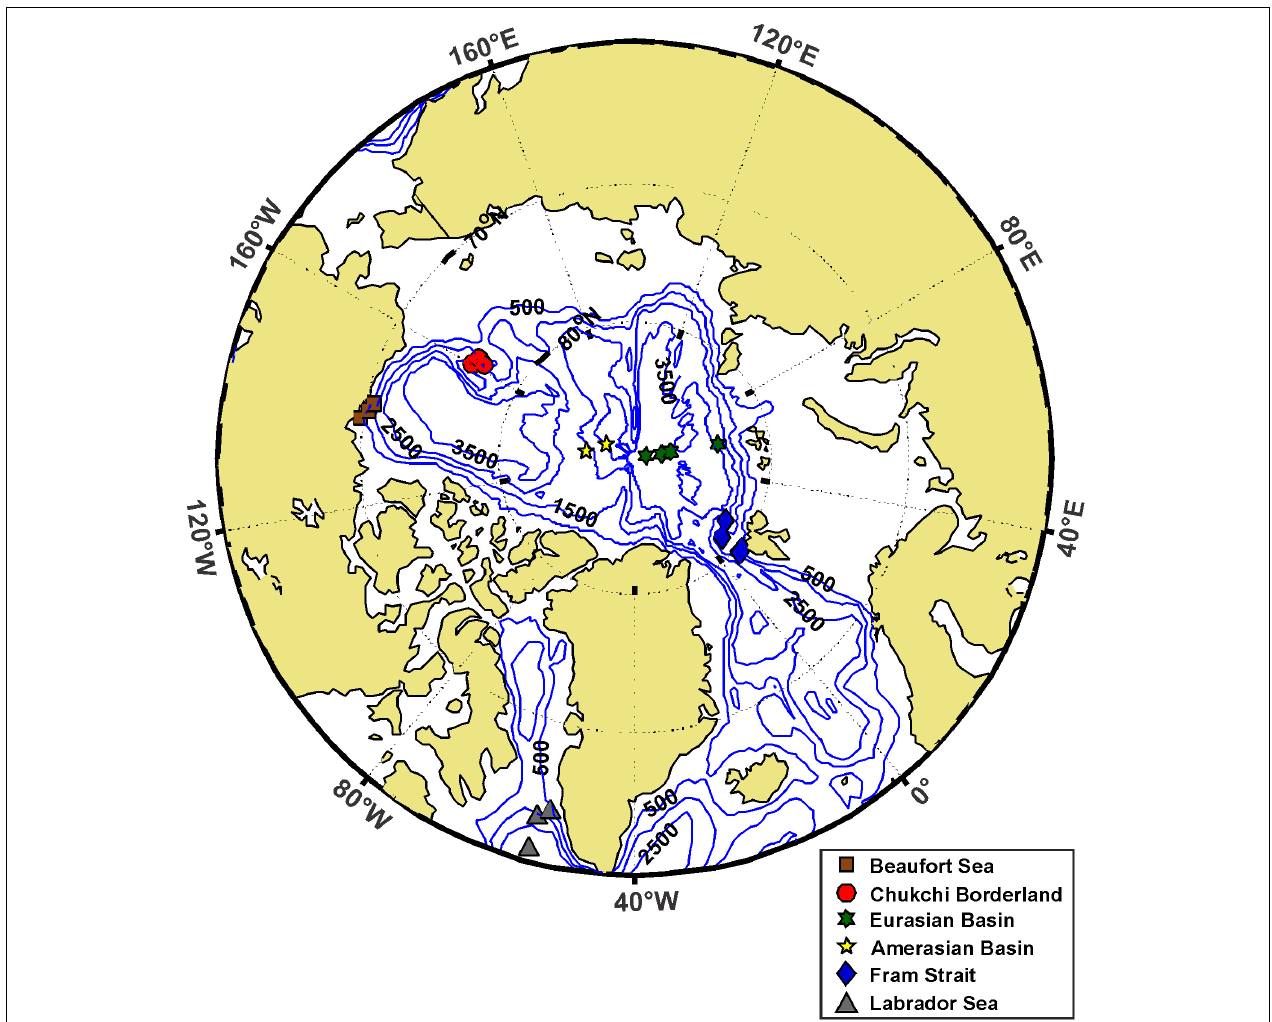
FIGURE 2 | Collection locations of samples from which Eukrohnia hamata was identified and analyzed for mtCOI barcode sequencing and ddRAD SNP detection for this study. Symbol shape and color indicate regional designation: Eurasian Basin, Amerasian Basins, Beaufort Sea, Chukchi Borderland, Fram Strait, and Labrador Sea. Numbers indicate depths (in meters) of the bathymetric contour lines. See Table 1 for collection